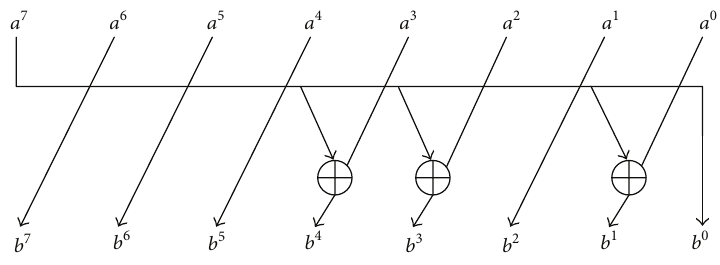
Figure 19: The xTime circuit.